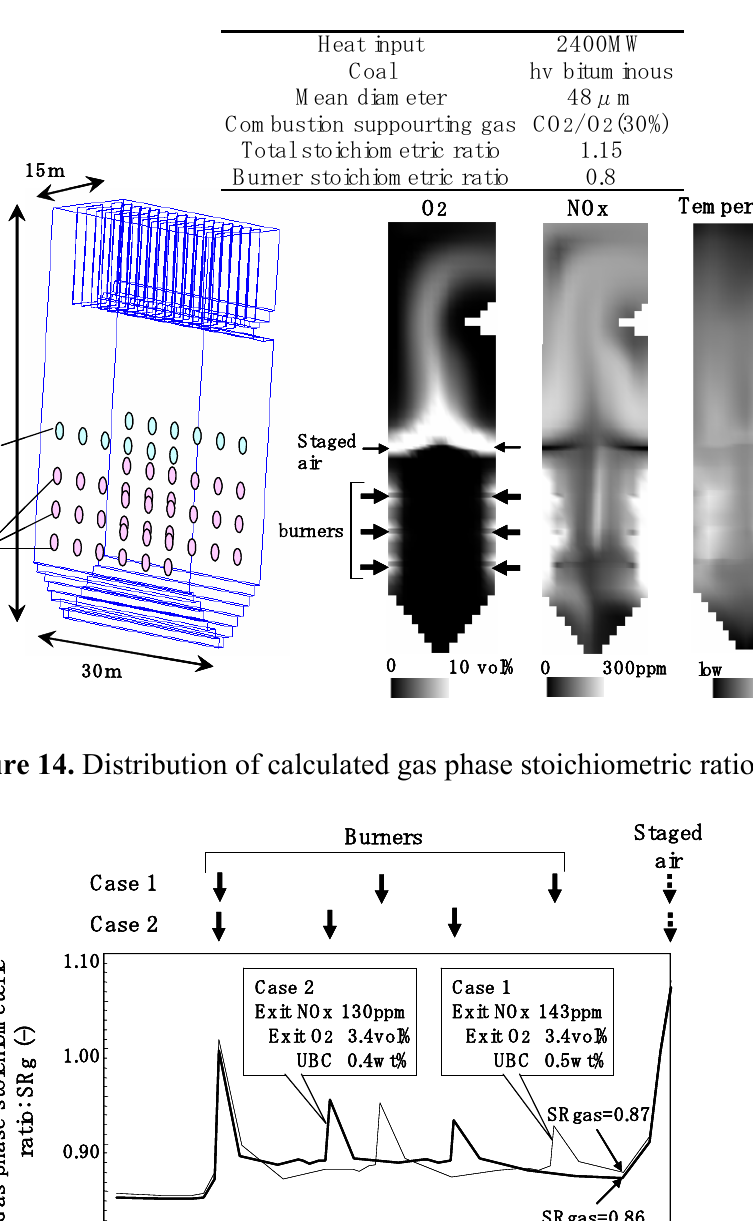
Figure 13. Numerical calculation for oxyfuel combustion.